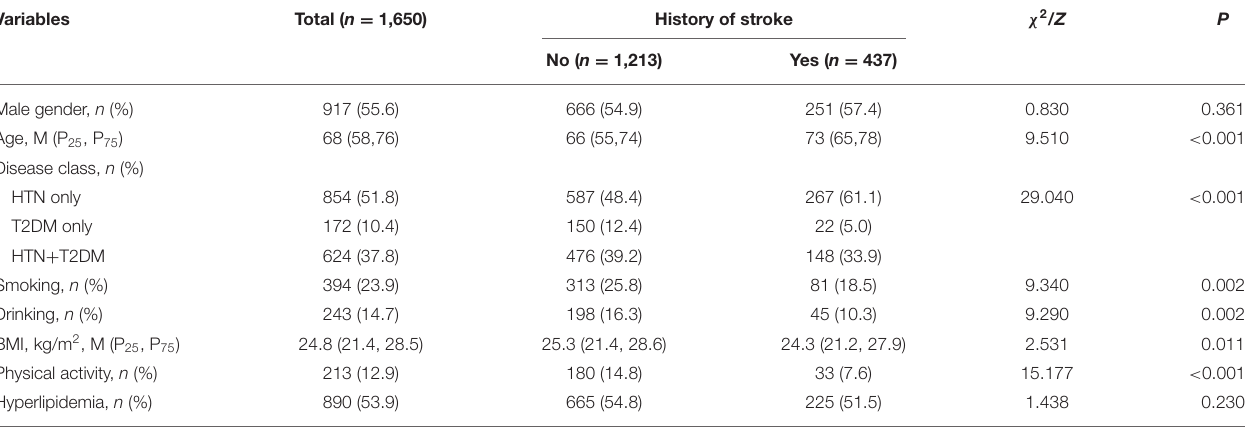
TABLE 1 | The characteristics of research objects ( n = 1,650). Variables